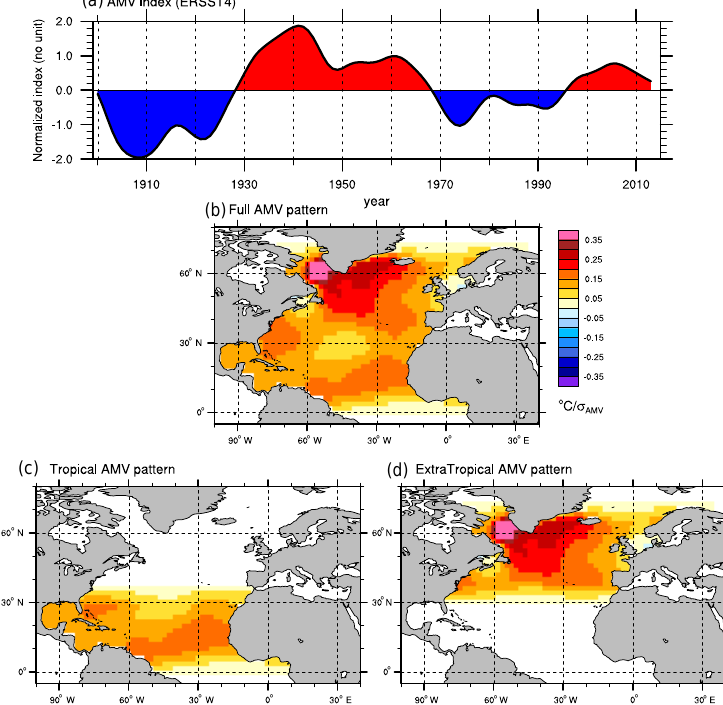
Figure 6. Idealized Atlantic SST patterns. The time series (upper panel) and pattern (middle panel) are derived following the procedure documented in Ting et al. (2009) using ERSSTv4 (Huang et al., 2015) as discussed in Technical Note 1 (available from the DCPP website at http://www.wcrp-climate.org/dcp-overview). Experiments C1.1 to C1.3 use the total AMV pattern (middle panel), whereas experiments C1.7 and C1.8 apply anomalies in the northern extra-tropics and tropics separately (lower panels).